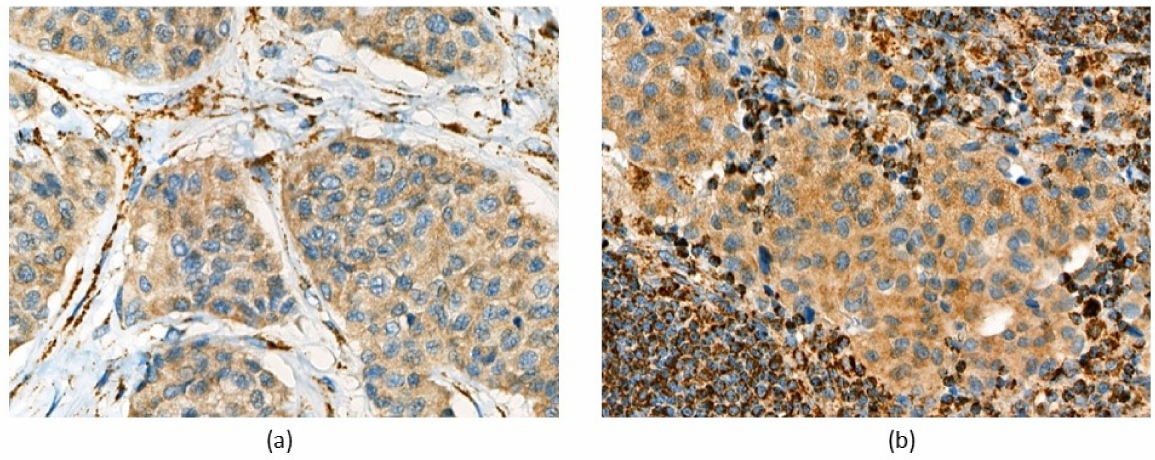
Figure 2. Immunohistochemical examination showed weak diffuse SDHB staining in ( a ) recurrent tumor and ( b ) metastasis of the patient. Magnification 400 ×